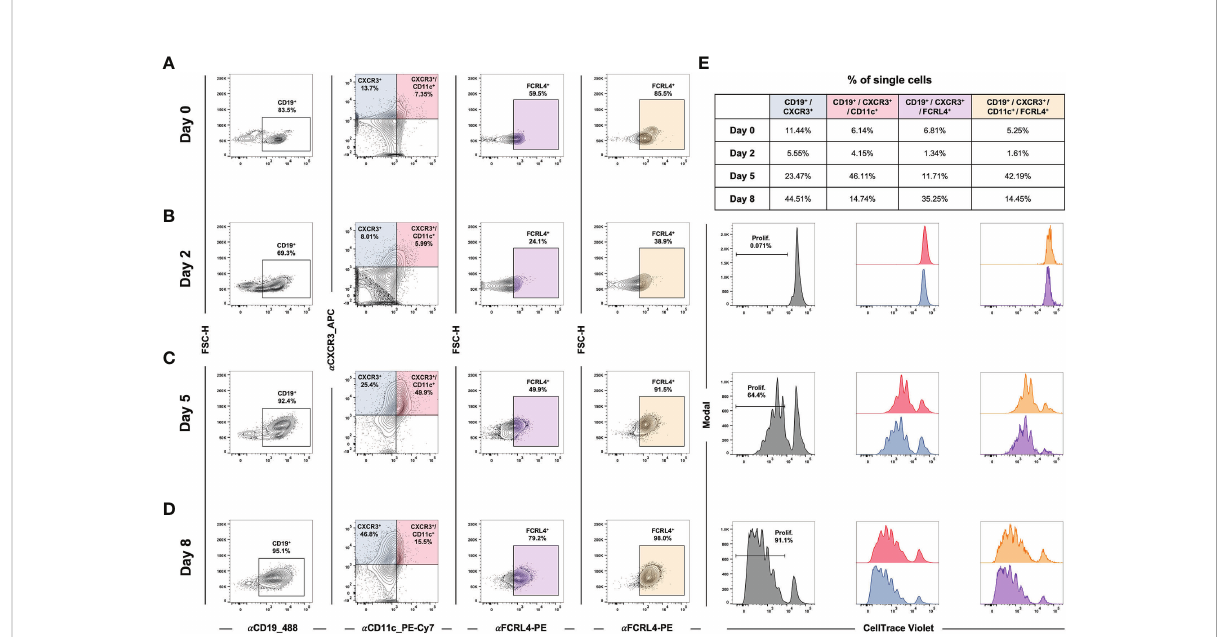
FIGURE 7 EBV de novo infection of peripheral B cells induces a CXCR3 + /CD11c + /FCRL4 + population that exhibits classic hyperproliferation. (A) Gating for CD19 + /CXCR3 + /CD11c + /FCRL4 + cells within uninfected B cells enriched from PBMCs. (B) Gating as in A) at Day 2 post-EBV infection. (C) Gating for Day 5 post-EBV infection. (D) Gating for Day 8 post-EBV infection. (E) Cell proliferation and distribution of division number over time by gated populations (all CD19 + , CD19 + /CXCR3 + /CD11c + , and CD19 + /CXCR3 + /CD11c + /FCRL4 +